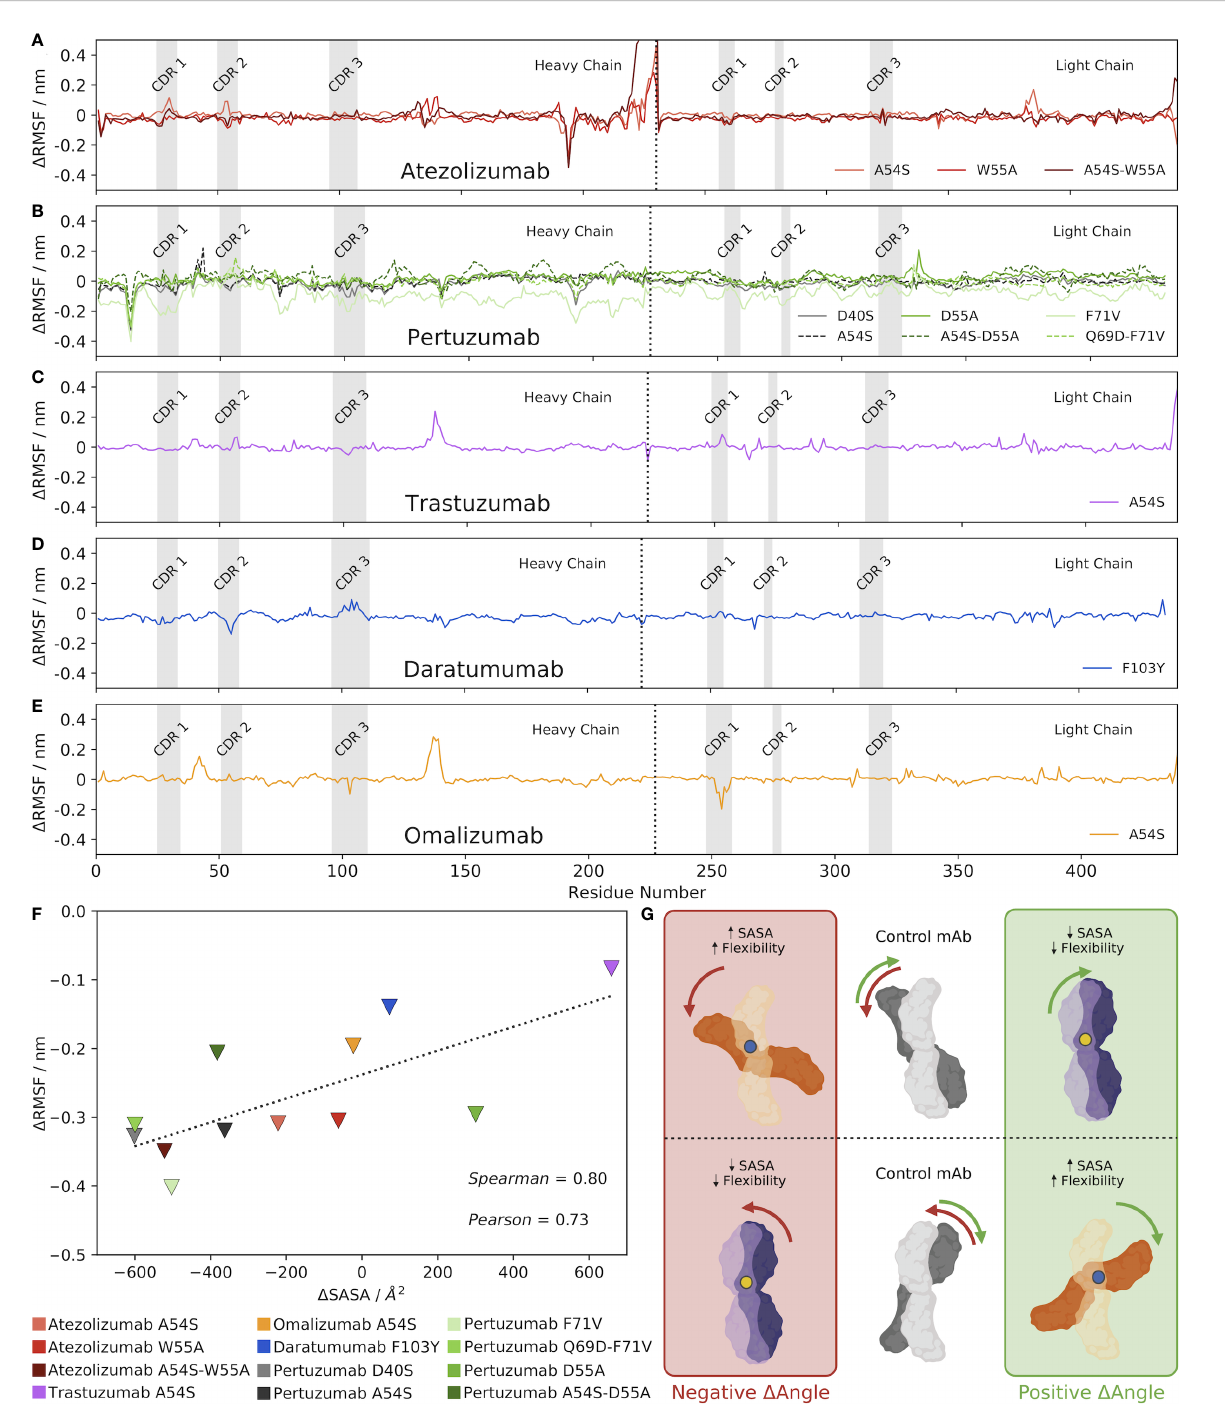
FIGURE 3 Mutations alter the V H -V L interface angle, altering the SASA of the Ab, which alters its overall fl exibility. (A – E) Changes in RMSF between each mutant Ab and the control, mature Ab. (F) Correlation between changes in Ab SASA and RMSD upon mutation, compared to the control Ab. Triangles depict the minimum changes in RMSF between the mutant and control Ab as the change in SASA shifts, with a dashed line included simply for ease of visualization. (G) Visual hypothesis of these results. The middle panel shows two example control states where the mature Ab is oriented with a speci fi c V H -V L interface angle. When a mutation is made, shown as either a blue or yellow dot, the V H -V L interface angle shifts. However, a positive change in V H -V L interface angle does not always indicate an increase in SASA. As shown in the diagram, an increase in SASA (and subsequently fl exibility) is a result of a blue mutation shown in the orange Abs. Conversely, a decrease in SASA (and subsequently fl exibility) is a result of a yellow mutation shown in the purple